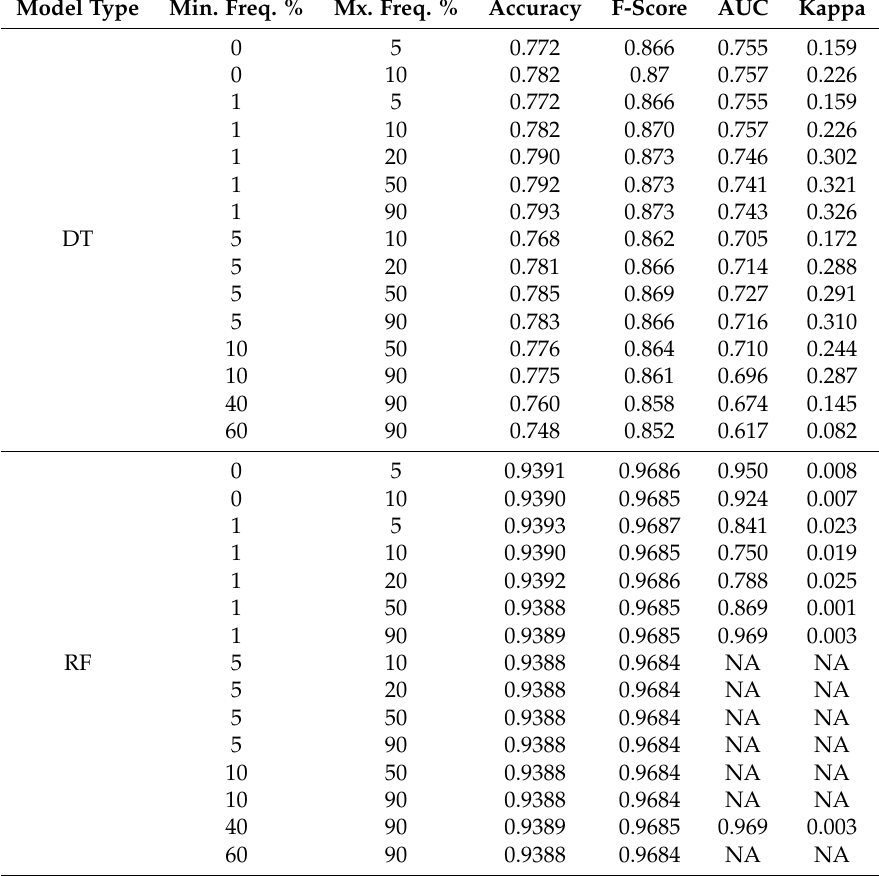
Table 1. Classification metrics results for generator failures with Decision Trees and Random Forest models. Min. frequency % and max. frequency % columns indicate the minimal and maximal frequency that a word has to be in the training dataset to be chosen to train the